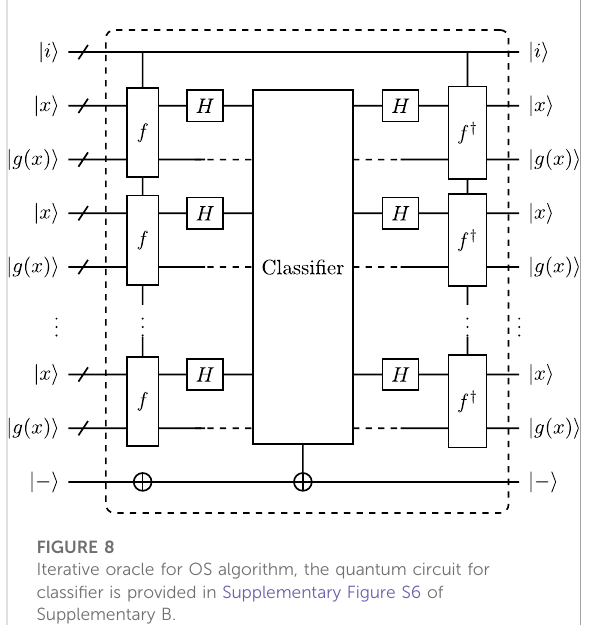
FIGURE 8 Iterative oracle for OS algorithm, the quantum circuit for classi fi er is provided in Supplementary Figure S6 of Supplementary B.